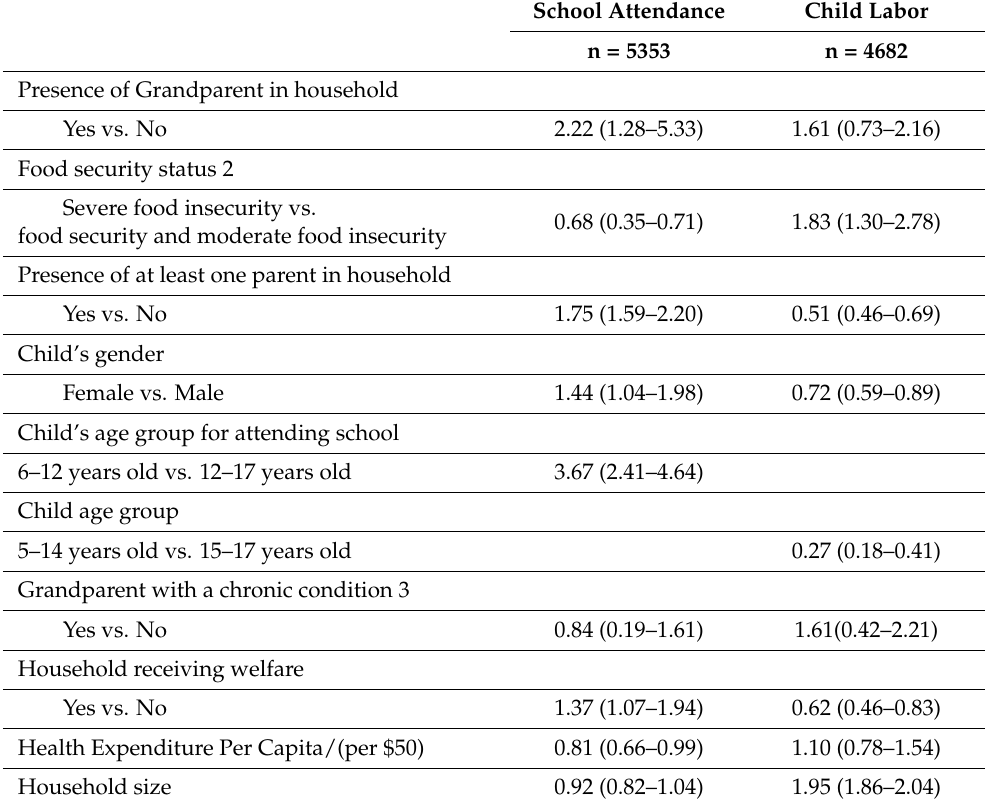
Table 5. Multivariate logistic regressions of factors associated with child (5–17 years) wellbeing in Palestinian refugee camps in Lebanon (2010 and 2015 Socio-Economic Surveys of Palestinian Refugees in Lebanon). 1